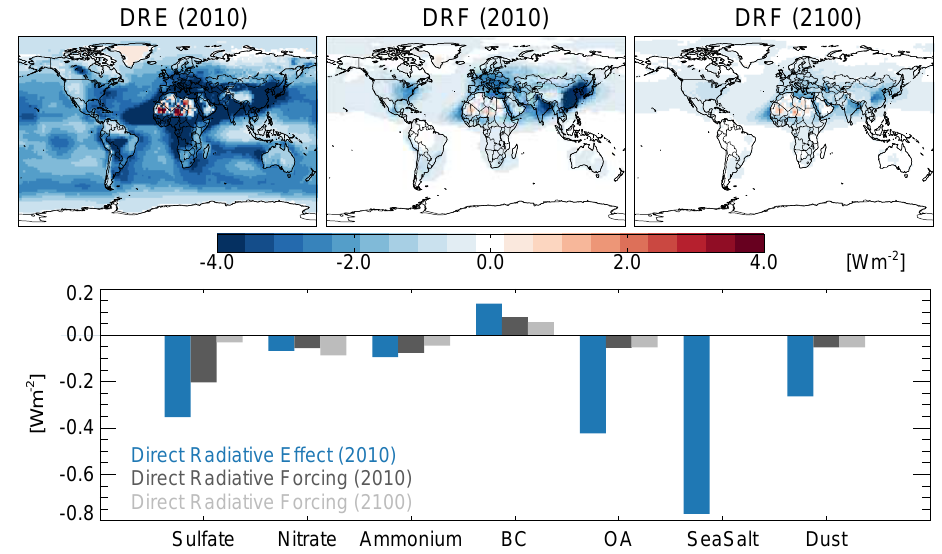
Figure 3. Top: global annual mean all-sky aerosol TOA direct radiative effect in 2010 (top left, blue), direct radiative forcing for 2010 (top center, dark gray) and direct radiative forcing for 2100 (top right, light gray). Mean values for 2010 are given in Table